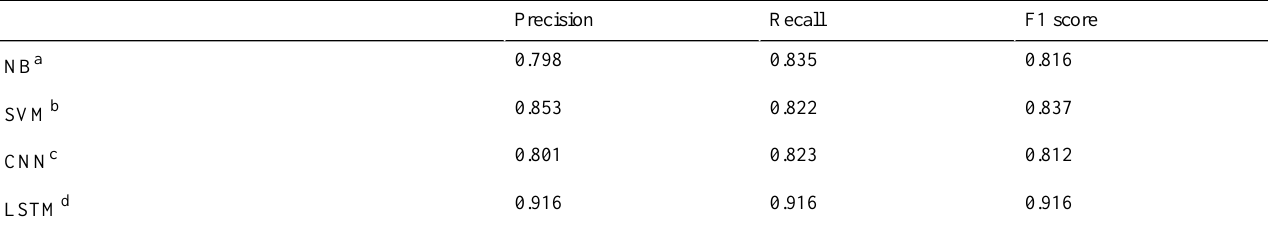
Table 1. Performance of the models for sentiment polarity classification.